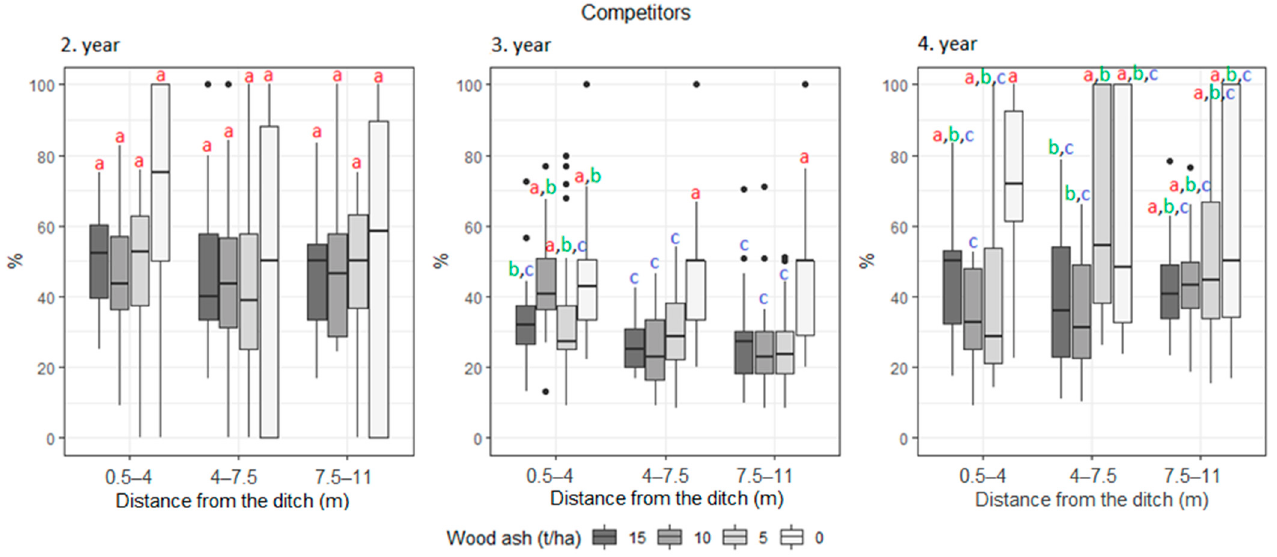
Figure A8. Relative of plants with competitor universal adaptive strategy from the total vegetation cover, depending on the distance from the drainage ditch and the dose of wood-ash fertiliser. Different letters (a, b, c) indicate significant differences between groups, p < 0.05 according to the Tukey HSD test.